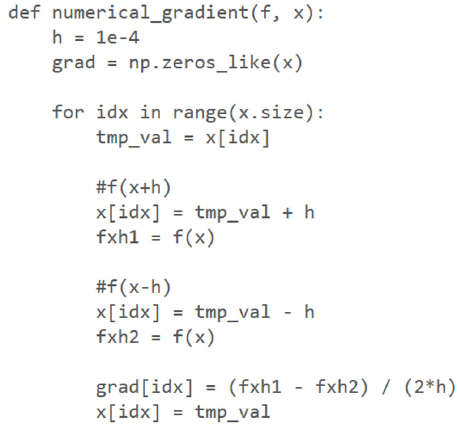
Figure 10. Source result for gradient.